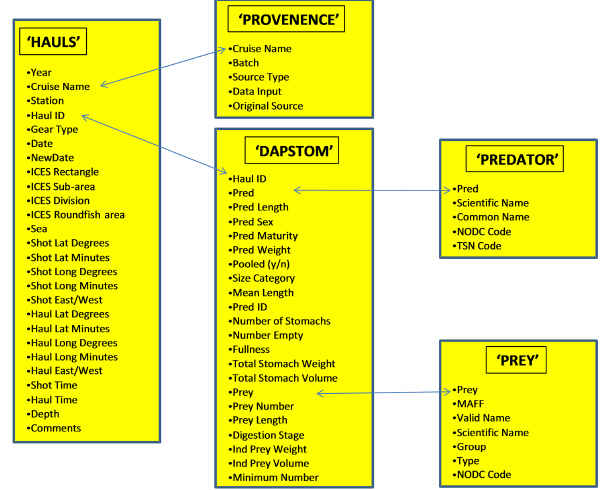
Figure 1. Structure of the DAPSTOM 4.7 relational database, in- cluding a list of the fields contained within each table. For a full de- scription of the field formats and nomenclature see Pinnegar